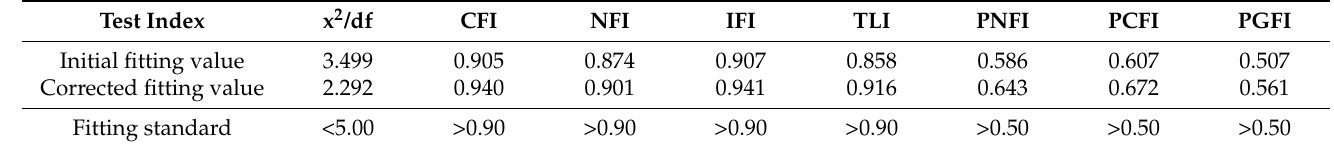
Figure 2. Structural equation model of farmers’ satisfaction regarding land expropriation system reform. Table 7. Modified model fitting degree test index results.